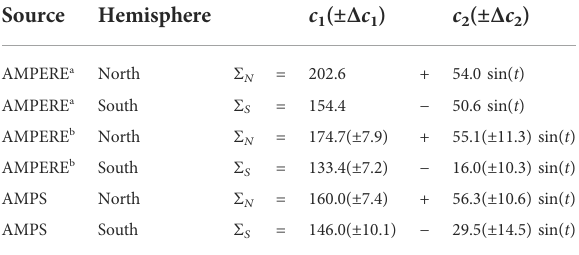
TABLE 1 Global conductances estimated from Eq.